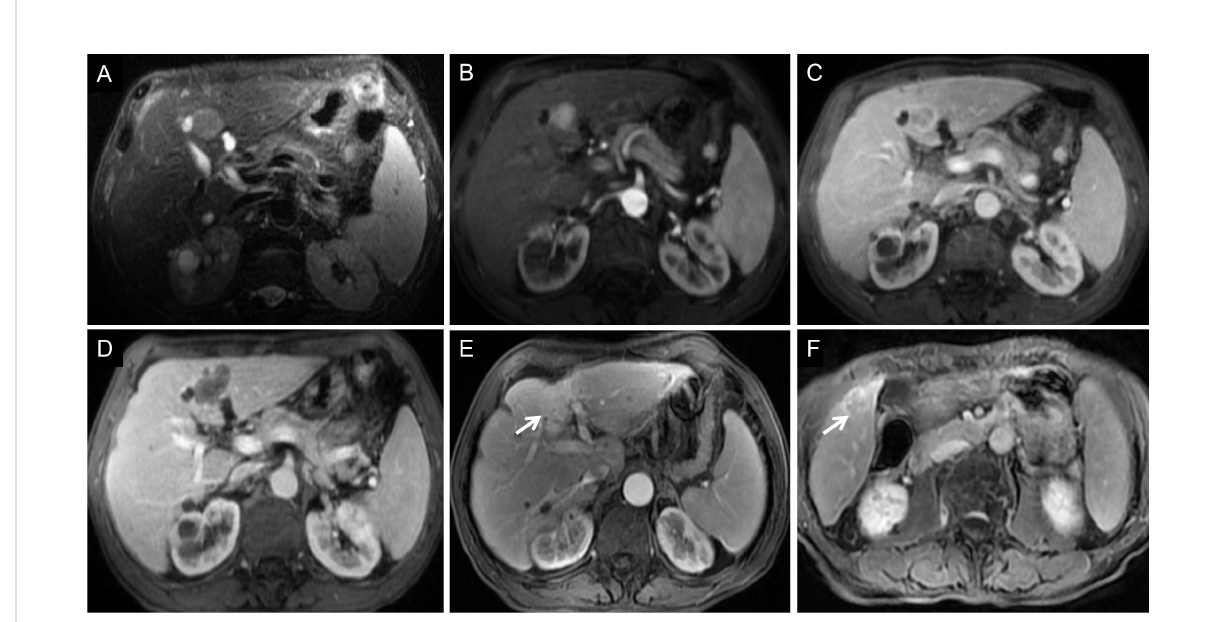
FIGURE 8 Images of a 68-year-old man with HCC with early recurrence. (A-C) The tumor demonstrated the typical enhancement mode of “ fast in and fast out ” . (D) No obvious blood supply was found in the tumor after RFA. (E-F) After follow-up for 15 months, the blood supply of the primary lesion increased, and cancerous nodules appeared in the right posterior lobe of the liver. The patient had a single tumor. The Rad-score of this patient was -1.00, and his ALB was 33g/l. According to the Nomogram, the patient ’ s total score was about 110, indicating that the risk of ER was between